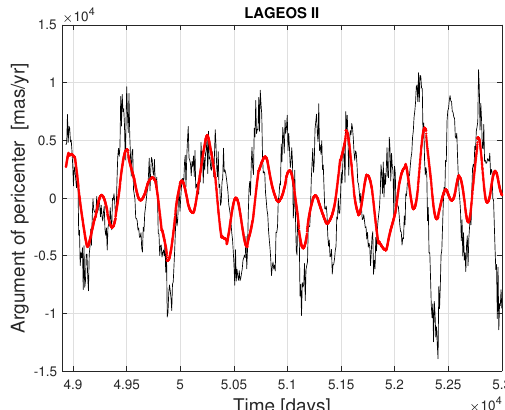
Figure 10. Yarkovsky-Schach effect on the rate of change of LAGEOS II argument of pericenter. The predictions of the simplified thermal model (red line) are compared with the residuals in the argument of pericenter (black line) obtained by means of a POD performed over the same time span of 4080